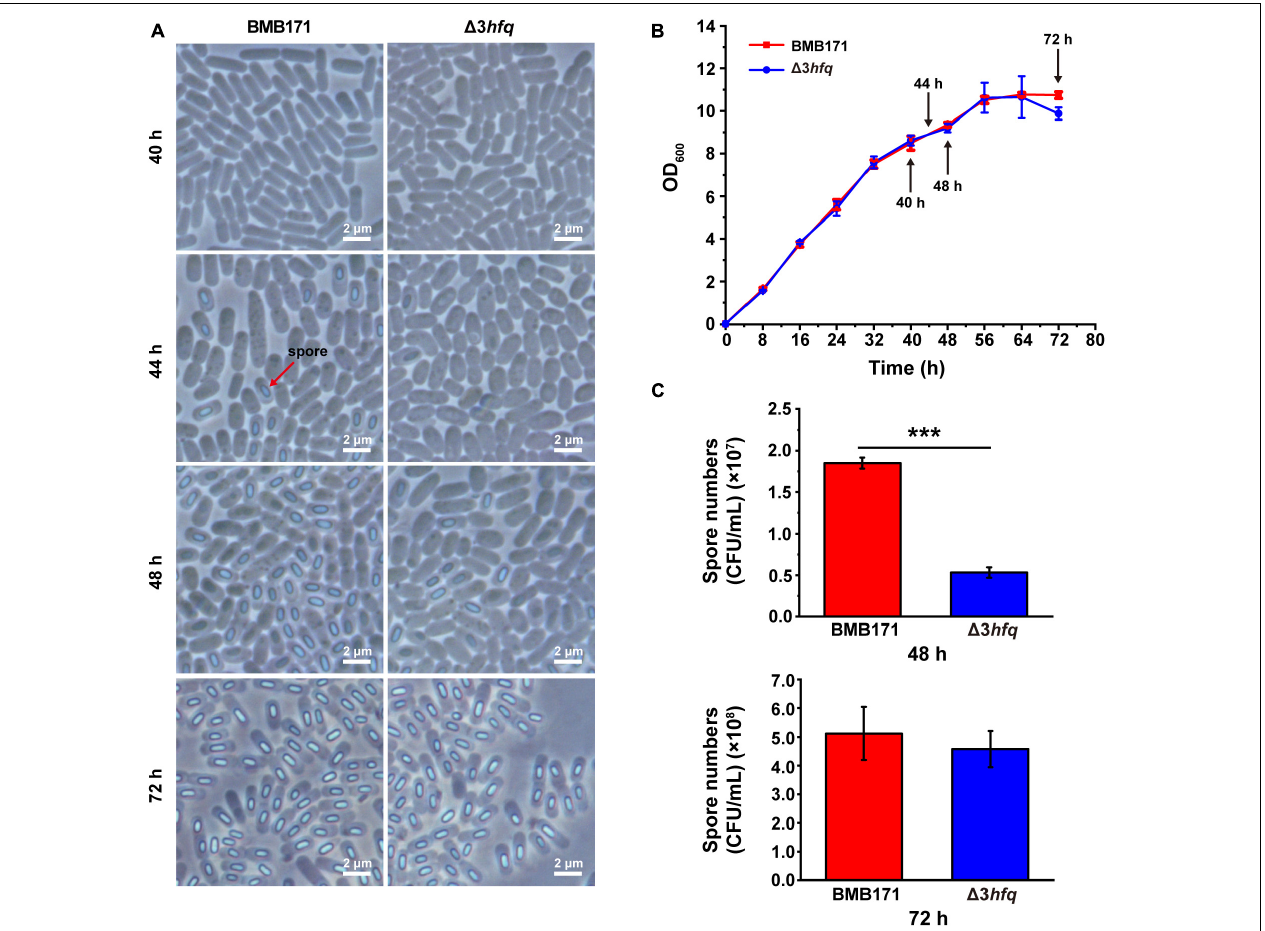
FIGURE 4 | Deletion of hfq results in delayed sporulation. (A) Morphologies of spores in BMB171 and (cid:49) 3 hfq was visualized by phase-contrast microscope at 40, 44, 48, and 72 h. The scale bar is 2 µ m. (B) Growth curves of BMB171 and (cid:49) 3 hfq . (C) Spore counting results of BMB171 and (cid:49) 3 hfq at 48 and 72 h. The values are means ± SDs for triplicate assays. The significances of differences by Student’s t -test are indicated. *** p < 0.001; ** p < 0.01; * p <